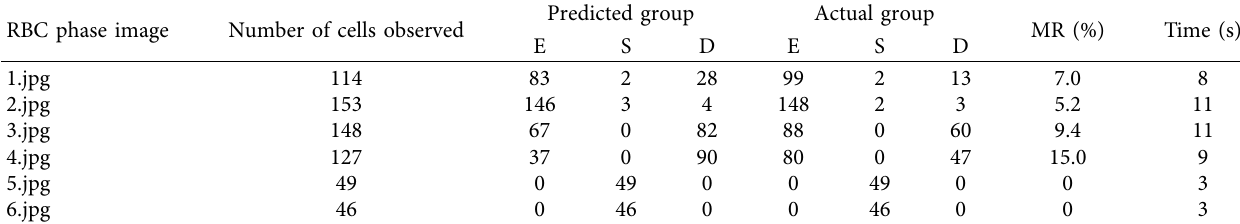
Table 3: Classification of RBCs based on the CNN